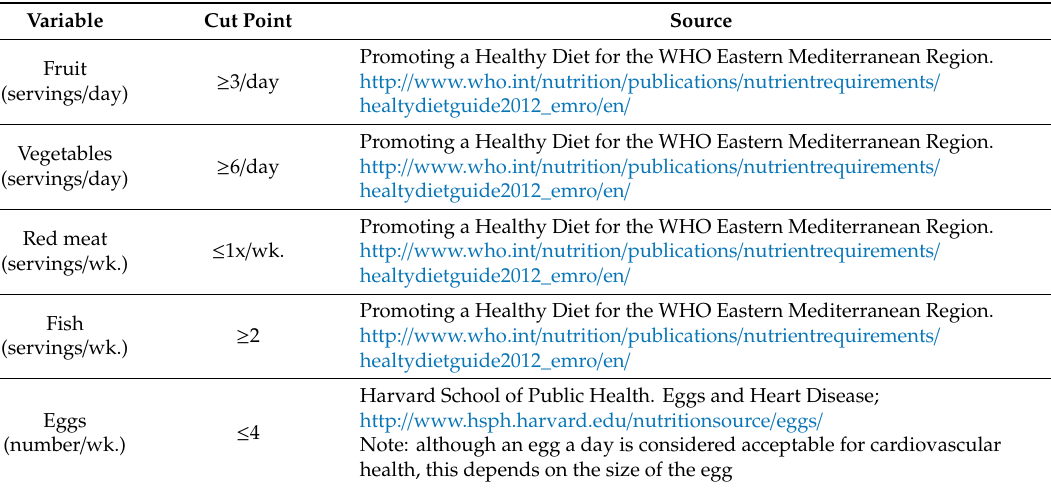
Table A1. Cut points for health